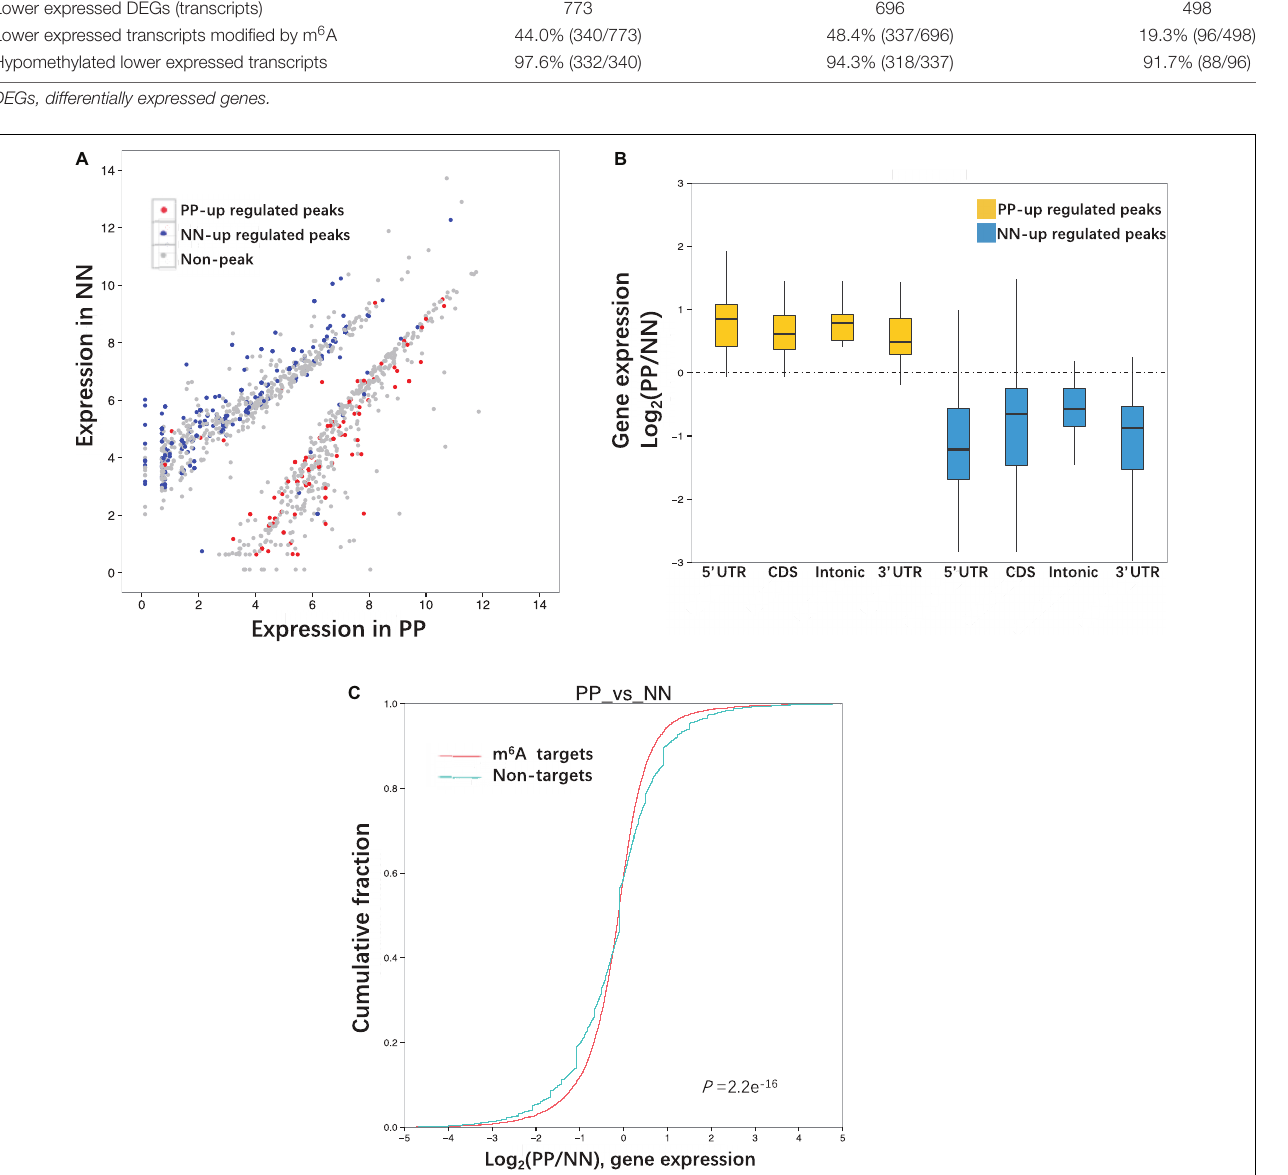
FIGURE 4 | Relationship between m 6 A peaks and mRNA level. (A) Differentially expressed genes (transcripts) in PP and NN. Genes contained up-regulated m 6 A peaks are highlighted in red and genes contained down- regulated m 6 A peaks are highlighted in blue. (B) The ratio of gene expression levels in PP and NN samples containing up-regulated m 6 A peaks. Genes are divided into four categories (5 (cid:48) UTR, CDS, Intonic, 3 (cid:48) UTR) according to the peak positions. (C) Cumulative distribution of mRNA expression changes between PP and NN for m 6 A -modified genes (red) and non-target genes (green). P -values are calculated by two-sided Mann–Whitney